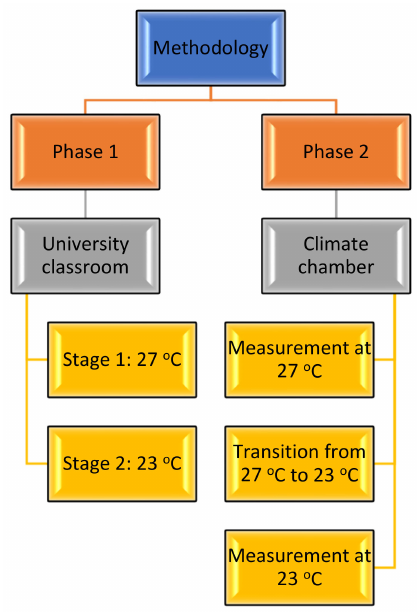
Figure 1. Flowchart of the experimental